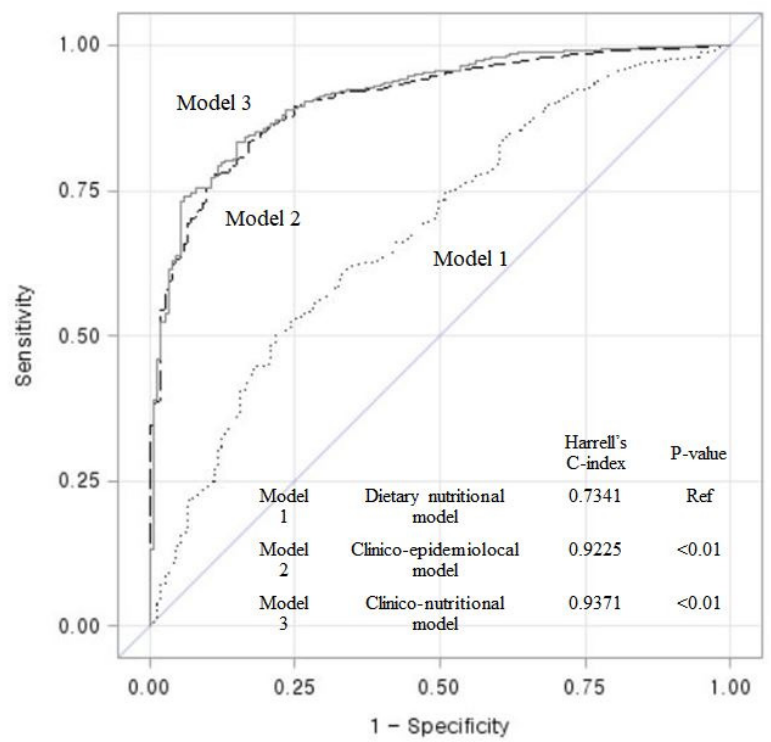
Figure 2. Receiver operating characteristic (ROC) curves and Harrell’s C-index showing the dis- criminant accuracy of each model for the ability to distinguish new cases of CKD stage 3B and over in the entire cohort population over 12 year follow-up periods. CKD, chronic kidney disease. Model